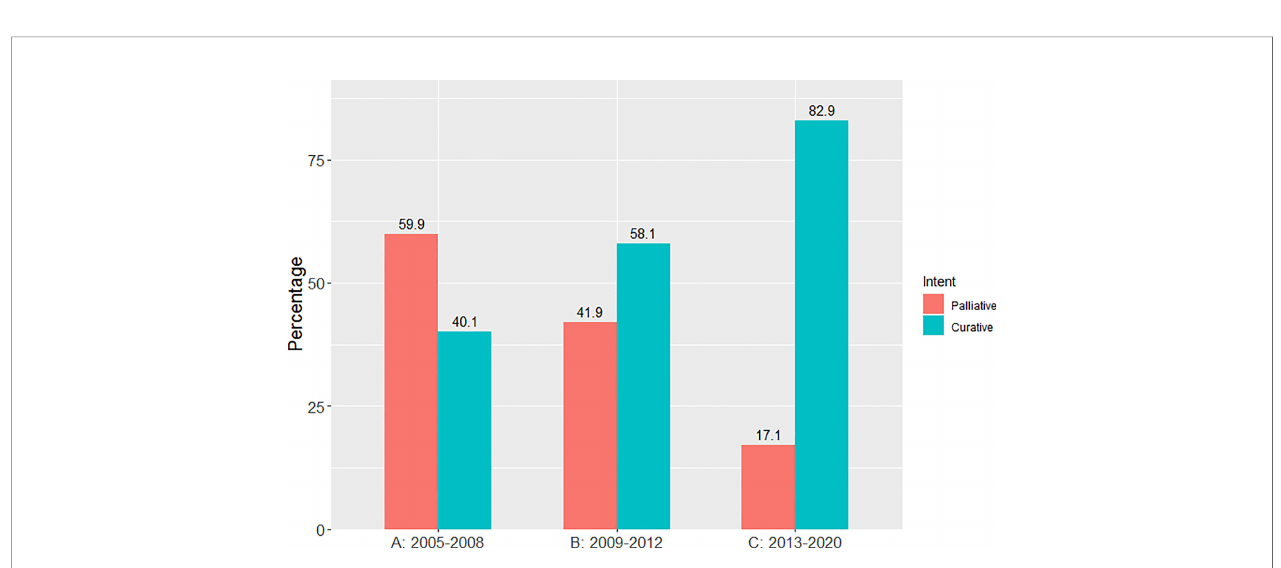
FIGURE 3 | Percentage of patients treated with curative versus palliative intent radiotherapy (stages I-III) in each of the pre-speci fi ed time